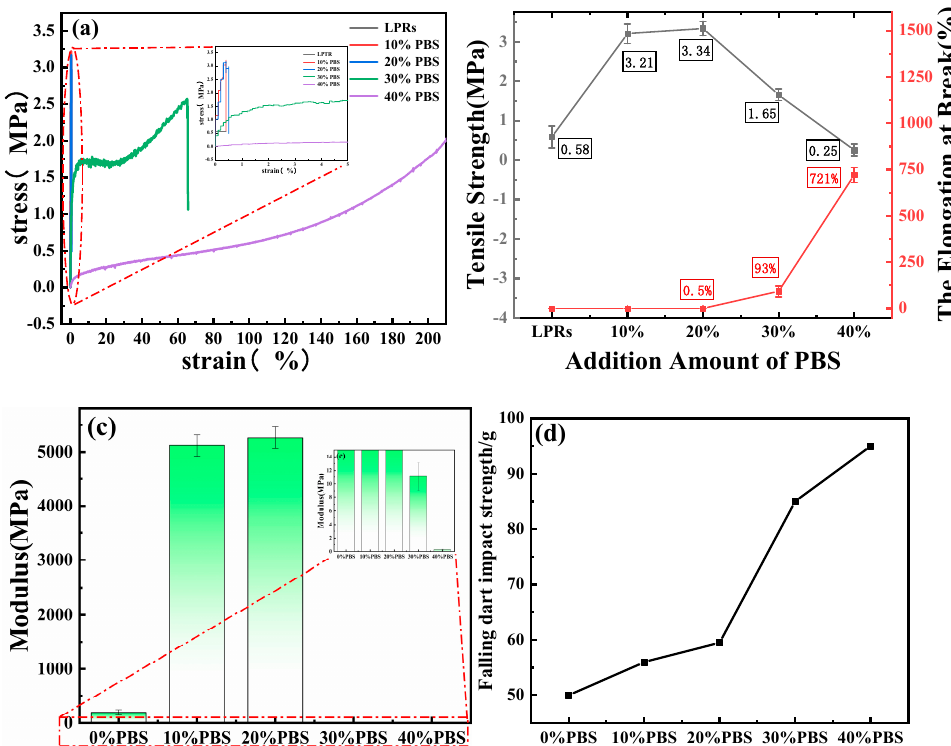
Figure 8. ( a ) Stress ‒ strain diagram; ( b ) tensile strength vs. elongation at break; ( c ) tensile modulus; and ( d ) falling dart impact strength.